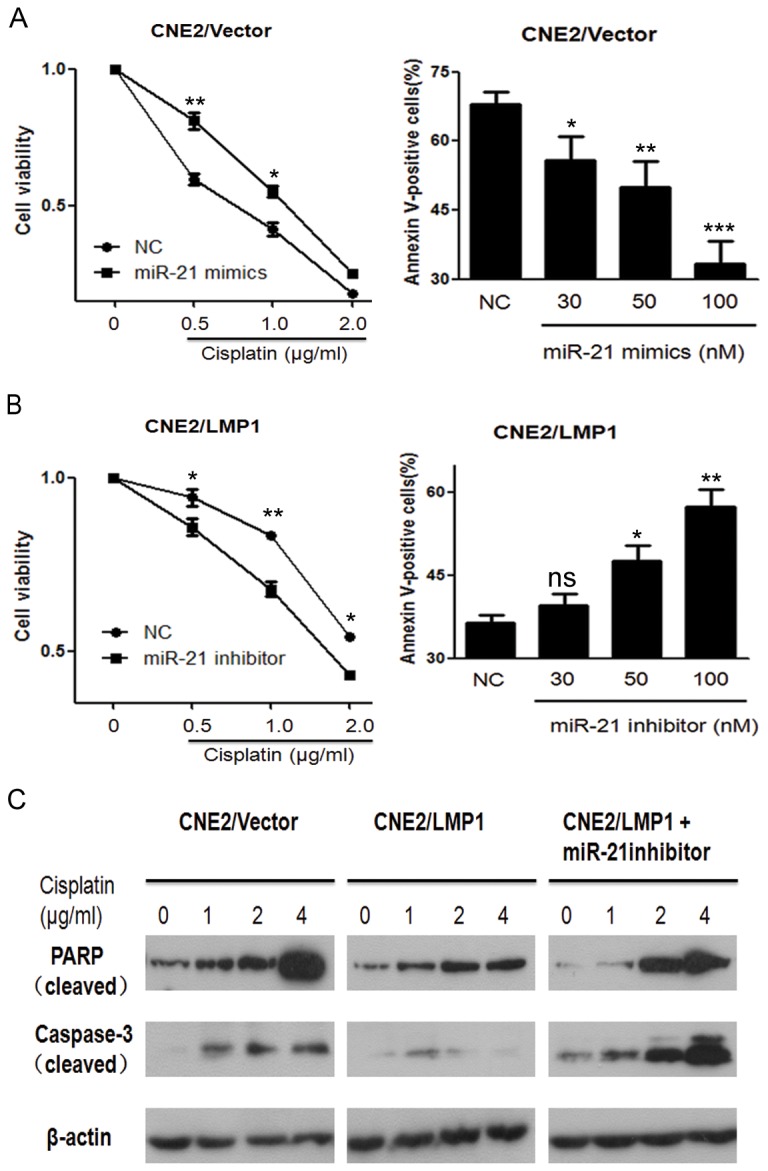
miR-21 plays an important role in cisplatin resistance in NPC cells.(A,B) CNE2/Vector (A) and CNE2/LMP1 (B) cells transfected with 50 nM miR-21 mimics or inhibitors or negative controls were treated with increasing concentrations of cisplatin for 72h. Cellular viability was analyzed by the MTT assay. CNE2/Vector (A) and CNE2/LMP1 (B) cells were transfected with increasing doses of miR-21 mimics or inhibitors or negative controls for 24 h, and then treated with 3 μg/ml cisplatin for 48 h. Cells were harvested for flow cytometry to detect apoptosis by staining with Annexin V/PI (ns, not significant; * P < 0.05; ** P < 0.01; *** P < 0.001 vs negative control transfected cells). (C) CNE2/Vector, CNE2/LMP1 and CNE2/LMP1 cells transfected with miR-21 inhibitor (50 nM for 6h) were treated with increasing doses of cisplatin for 24 h, and then harvested to analyze the expression of cleaved PARP and cleaved caspase-3 by immunoblotting.